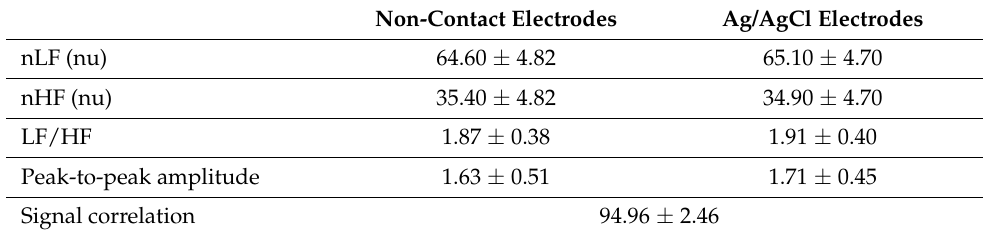
Table 1. Comparison between ECG signal qualities obtained by different electrodes.